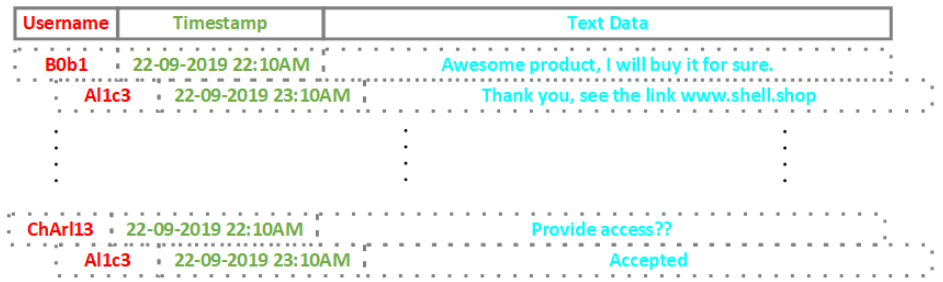
Figure 3. Typical Message Structure.